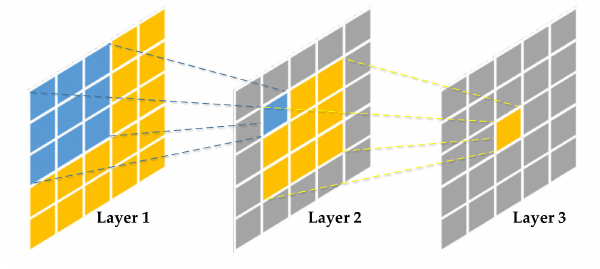
Figure 1. Schematic diagram of the receptive field in